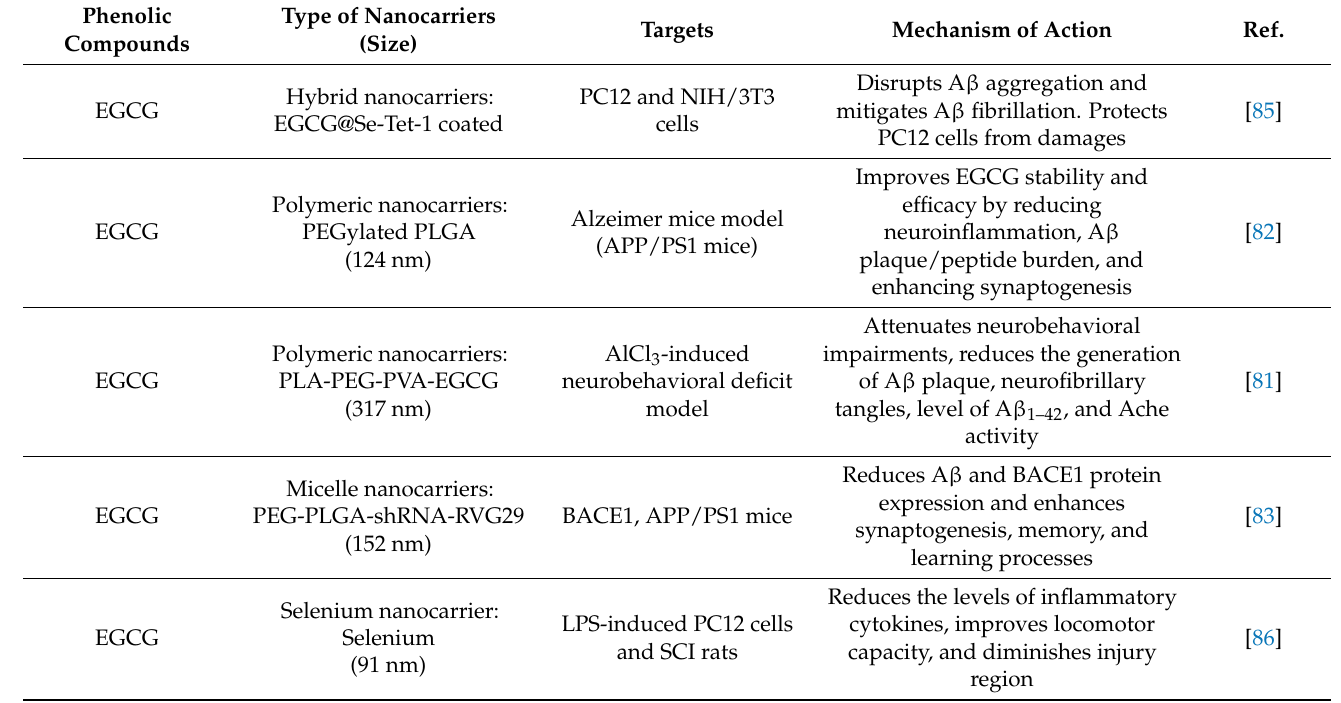
Table 1. Application of phenolic-loaded nanocarriers in neurodegenerative diseases.